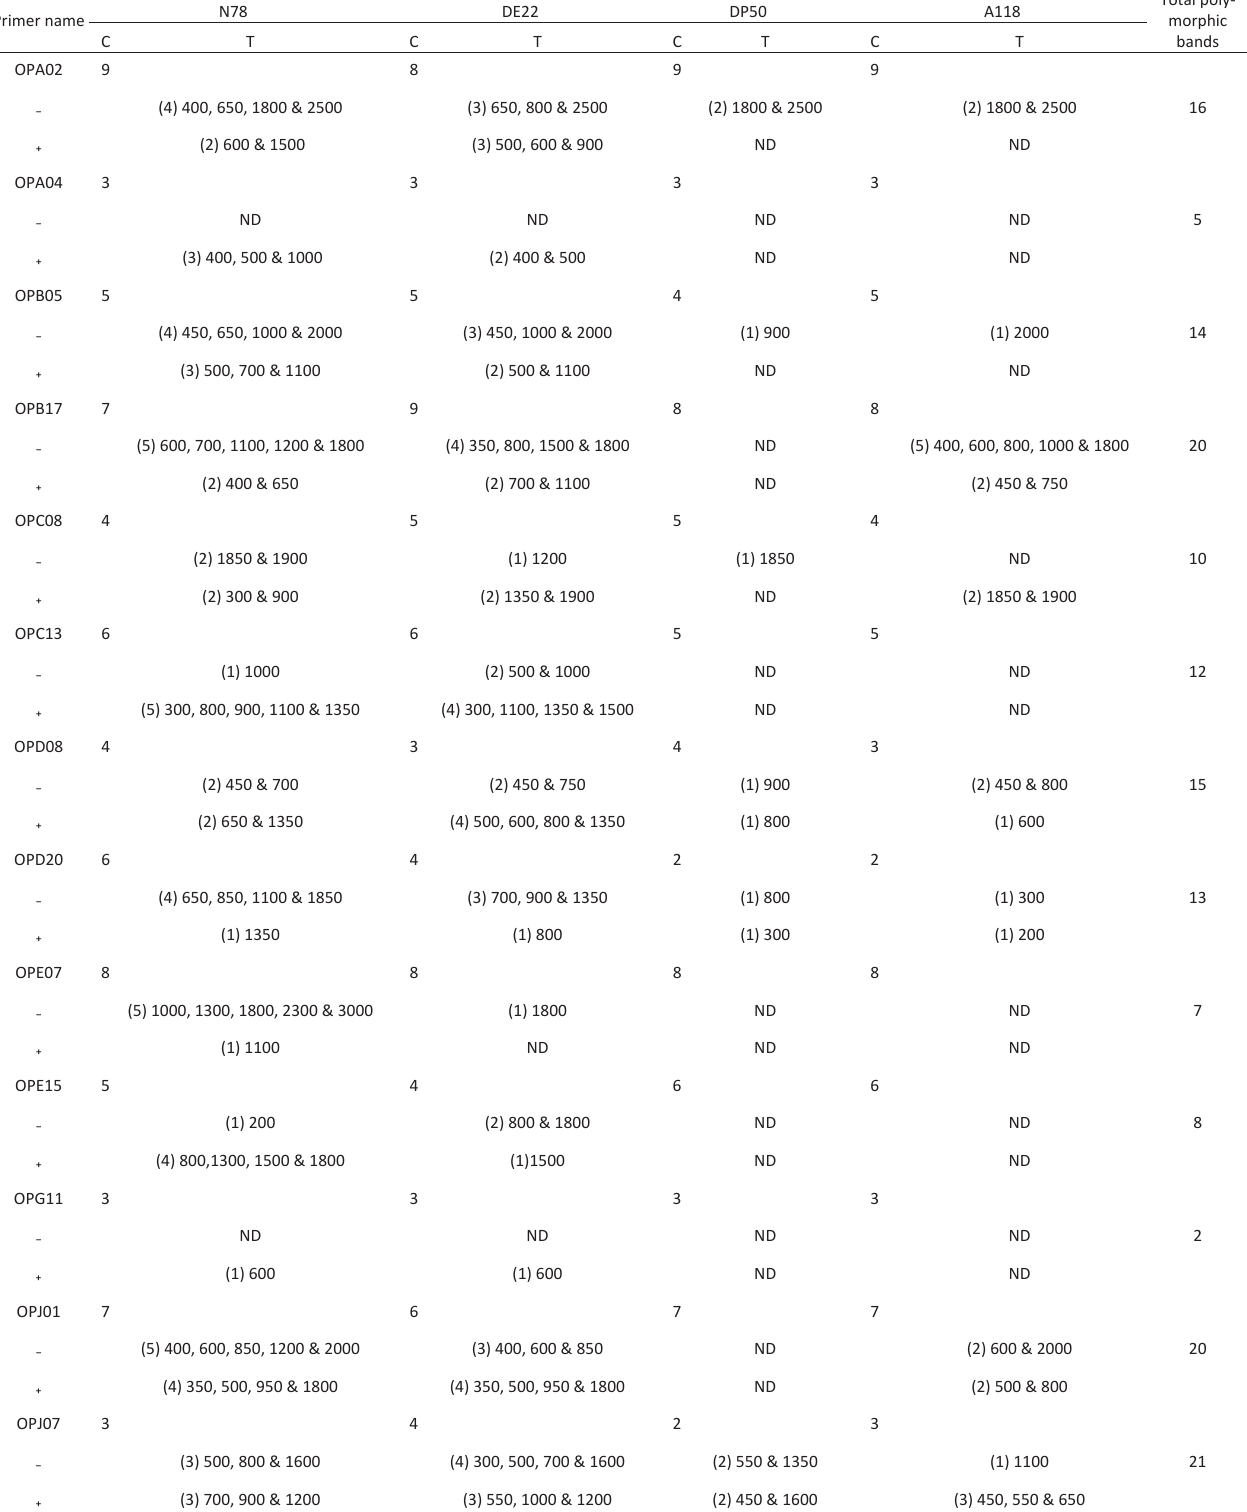
Table 2 - Markers identified by 26 RAPD primers for the four tested cotton varieties under salt stress compared to their respective con- trols. DNA changes induced by NaCl treatment using RAPD marker as described by loss or appearance of new bands (number and size) under salt stress compared to their respective controls for each variety